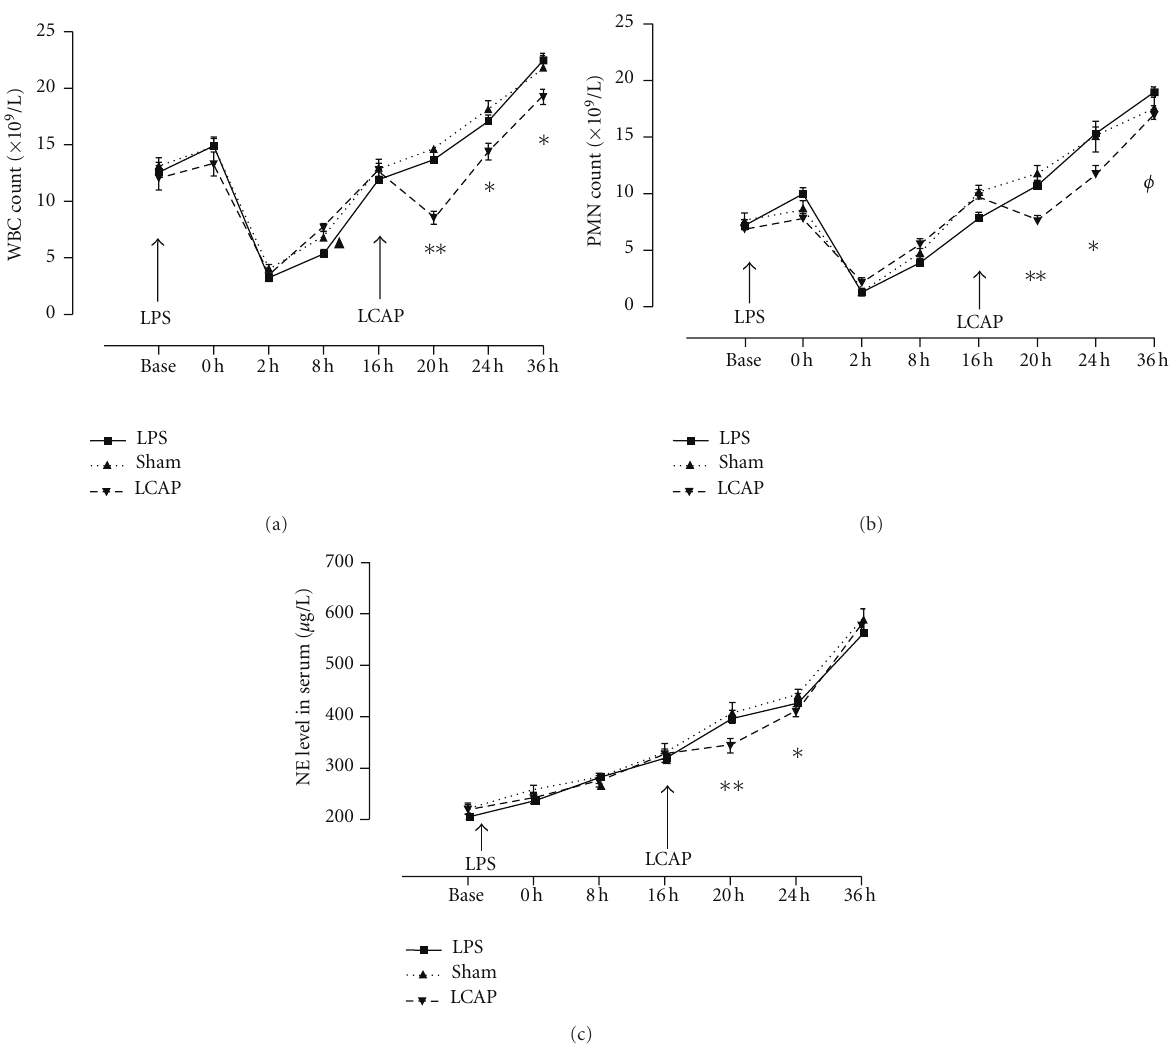
Figure 2: The e ff ect of LPS and LCAP on WBC and PMN counts and NE level in periphery. The numbers of WBCs and PMNs collected from the right femoral artery at indicated time periods after LPS injection were detected using the Digicell 500 cell counter and enumerated with Giemsa-Wright Stain. The animals in the LPS group underwent only LPS injection at the zero time point. Except for LPS administration, the animals in the sham-LCAP group underwent a sham-LCAP procedure (carried out by reinfusion of the end-products collected in a storage bag) at time point 16 h, for up to 4 h. and the animals in the LCAP group underwent both LPS injection and LCAP at corresponding time points. (a) WBC counts following the LPS injection and LCAP (/sham-LCAP). (b) PMN counts following LPS injection and LCAP (/sham-LCAP). (c) The level of NE following LPS injection and LCAP (/sham-LCAP). ∗ indicates significant di ff erence among the LCAP, LPS, and sham-LCAP groups at the indicated time ( ∗ P < 0 . 05; ∗∗ P < 0 . 01). # indicates significant di ff erence between the LCAP and LPS groups at the indicated time ( P < 0 .